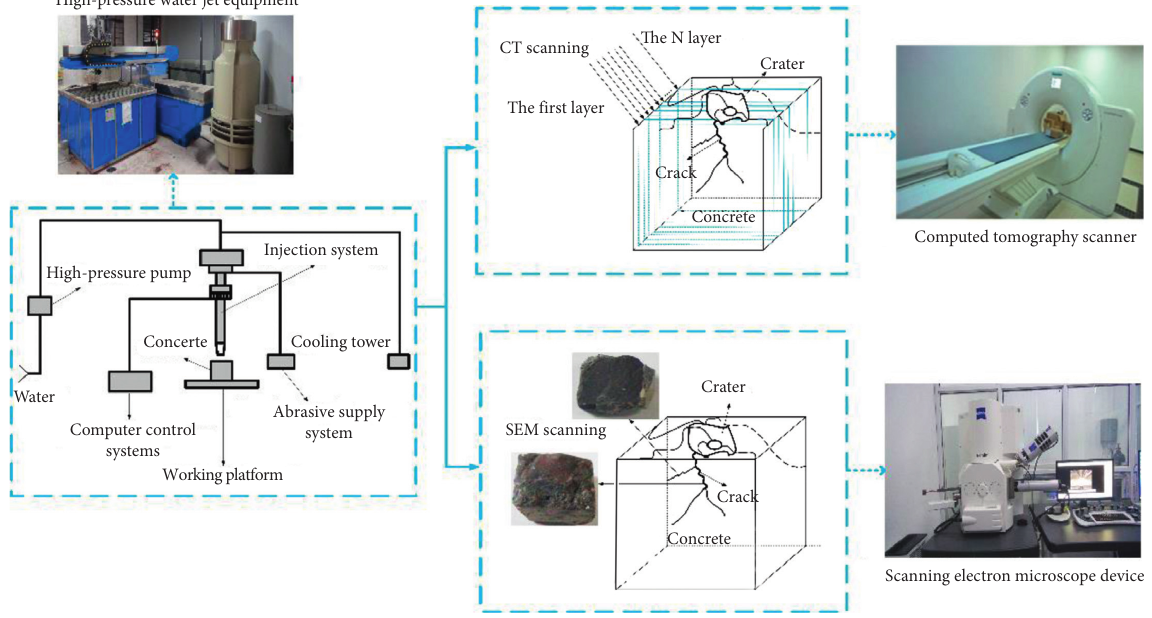
Figure 1: The experimental equipment and fundamental